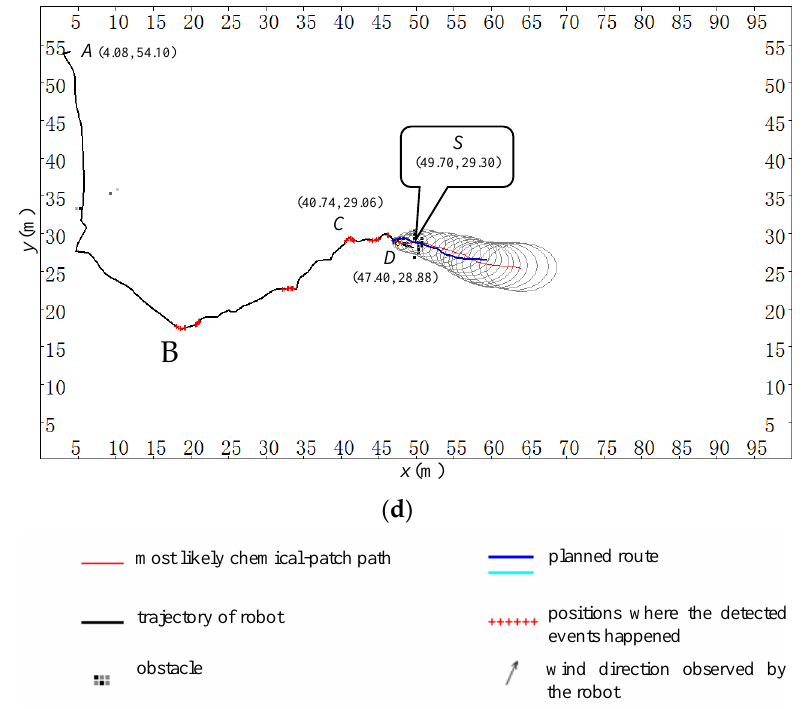
Figure 9. The process of chemical-clue finding and ERP procedure in the football field of Tianjin University. ( a ) t = 56.0 s. ( b ) t = 125.5 s. ( c ) t = 149.5 s. ( d ) t = 194.0 s. ‘ A ’ denotes the start position of the robot, ‘ S ’ indicates the true location of the chemical source, and ‘ B ’ is where the ERP procedure was launched. The planned route is represented by two colors, i.e., blue-black and cyan, corresponding to the two different parts SL u and SL d , respectively. Along the trajectory of the robot, each symbol ‘+’ represents a chemical-detection event. The solid arrow near the robot denotes the instantaneous wind direction observed by the robot. The trajectory of the robot from points ‘ A ’ to ‘ B ’ belongs to the chemical-clue-finding phase and the remaining part belongs to the ERP procedure. The timer began when the robot started to find chemical clue at point ‘ A ’. The total tracing time (excluding the chemical-clue-finding time) was 138.0 seconds.